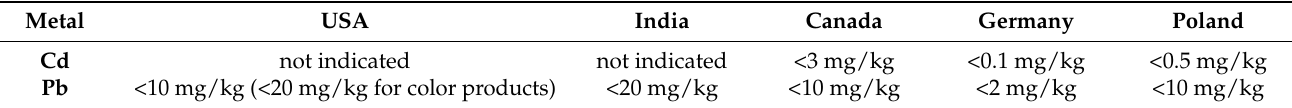
Table 1. Comparison of the permissible content of Pb and Cd (mg/kg) in cosmetics being in force in the USA, Canada, Germany and Poland